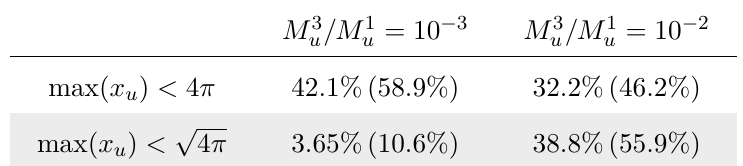
Table 2. Ratios of excluded parameter regions for the parameter sets in figure 4 from the current neutron EDM measurement, under an assumption of ¯ f 13 those in figure 5 under an assumption of ¯ f 13 perturbative bound of the Yukawa coupling x u as 4 π or